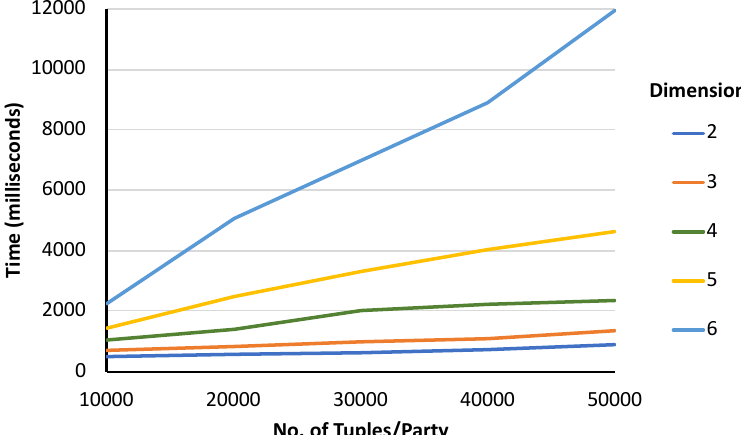
Figure 6. Running time varies with data dimension. [Data Distribution: Independent; Bit-slice length: 11-bit; Slices/Attribute: